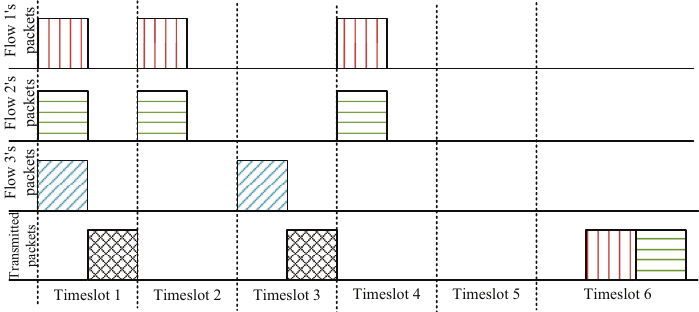
Figure 7. An example of the encoding